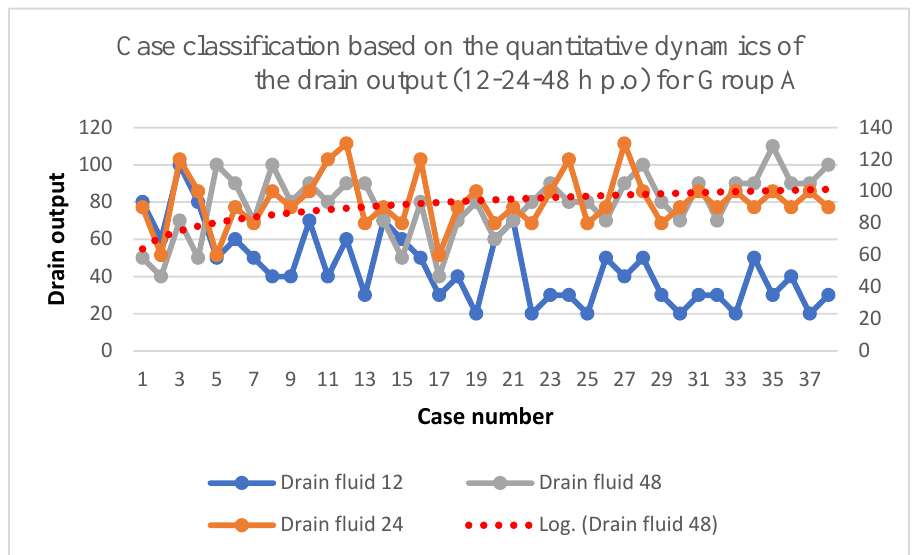
Figure 2. Quantitative dynamics of the drain output during the first 48 h for Group A.